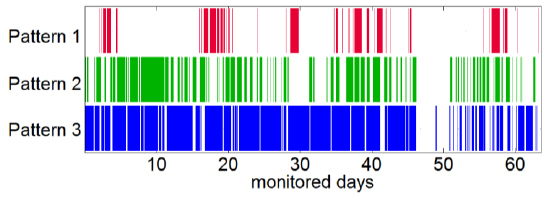
Figure 9. Results of recognition algorithm of determined Patterns 1–3 [14].